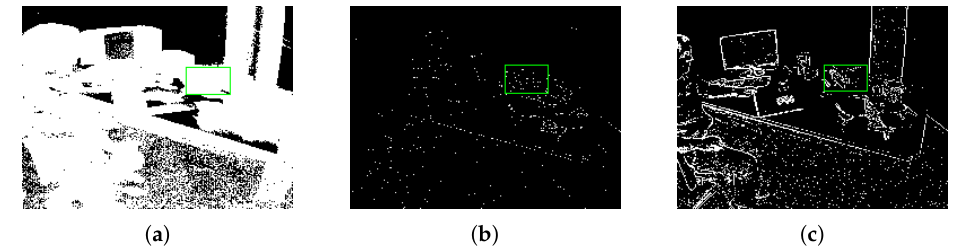
Figure 8. Here we use three strategies to reconstruct the event image. ( a ) shows the event frame reconstructed using the strategy of [28], and ( b ) shows the event image reconstructed using the strategy of [29]. ( c ) shows the event images reconstructed using our proposed strategy. In terms of visual comparison, the accumulation of too many event pixels in event image ( a ) causes the object to be blurred, while the event image ( b ) is too sparse to observe the object. Our event image has a clear object structure and edges. The green box represents the tracking object initialized in the first